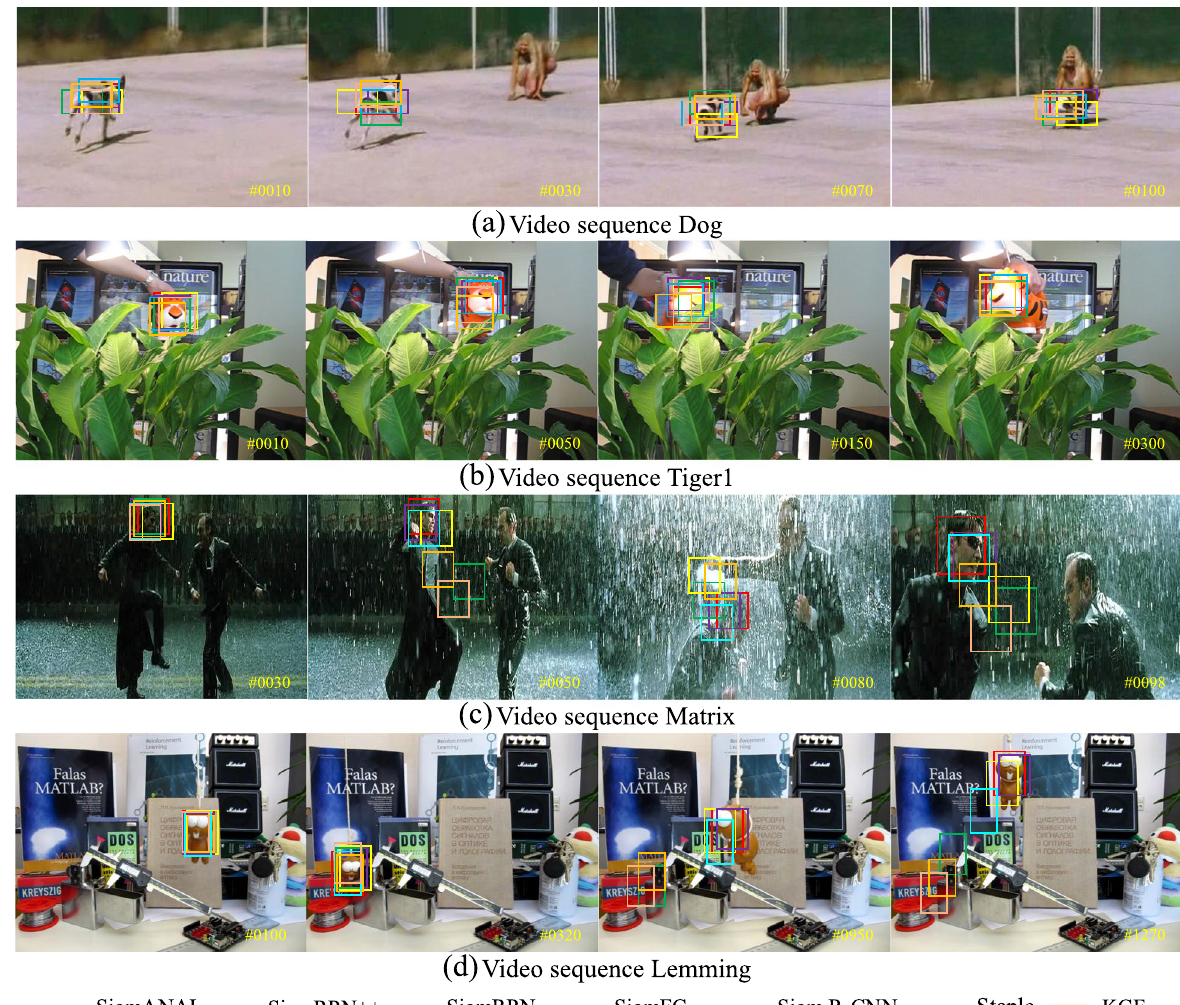
Fig. 10 Qualitative comparison in typical video sequences of the OTB100 benchmark. a Video sequence Dog. b Video sequence Tiger1. c Video sequence Matrix. d Video sequence